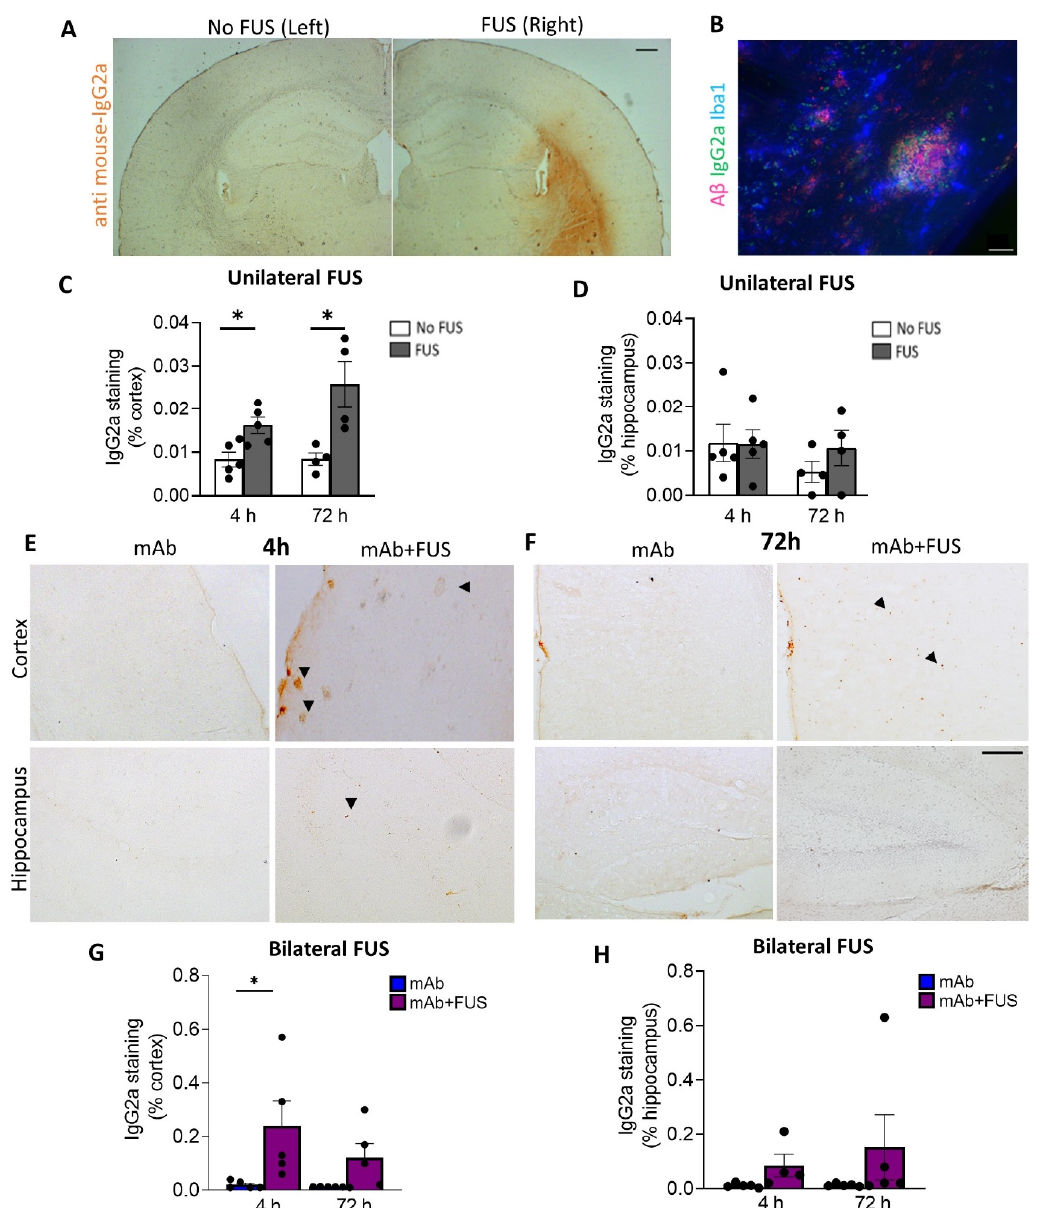
Figure 2. Focused ultrasound and IgG2a immunoreactivity (IR). ( A ) Representative DAB staining (anti mouse-IgG2a) for the left and right hemispheres in the unilateral FUS cohort. ( B ) Triple immunofluorescence labelling for Iba1, S97 (general Aβ) and anti-IgG2a indicating presence of antibody with Aβ plaques on the FUS side (right hemisphere). Unilateral FUS on the right hemisphere showed ( C ) increased anti-IgG2a IR in the cortex at 4 h ( p < 0.05) and 72 h ( p < 0.05) after 07/2a treatment and ( D ) no significant changes in the hippocampus; paired- t -test. ( E , F ) Cortical and hippocampal anti-IgG2a IR in the bilateral FUS cohort at 4 h and 72 h post-treatment. Arrowheads indicating IgG2a IR with some possible staining around plaques. Increased anti-IgG2a IR was found in the ( G ) cortex and ( H ) hippocampi after combination treatment at both time points, however, a significant increase was found in the cortex at 4 h. Black dots represent data from individual mice. Two-Way ANOVA, with Bonferroni’s multiple comparison test *, p < 0.05. Scale bar, ( A ) = 200µm and ( B , E ) = 20 µm.